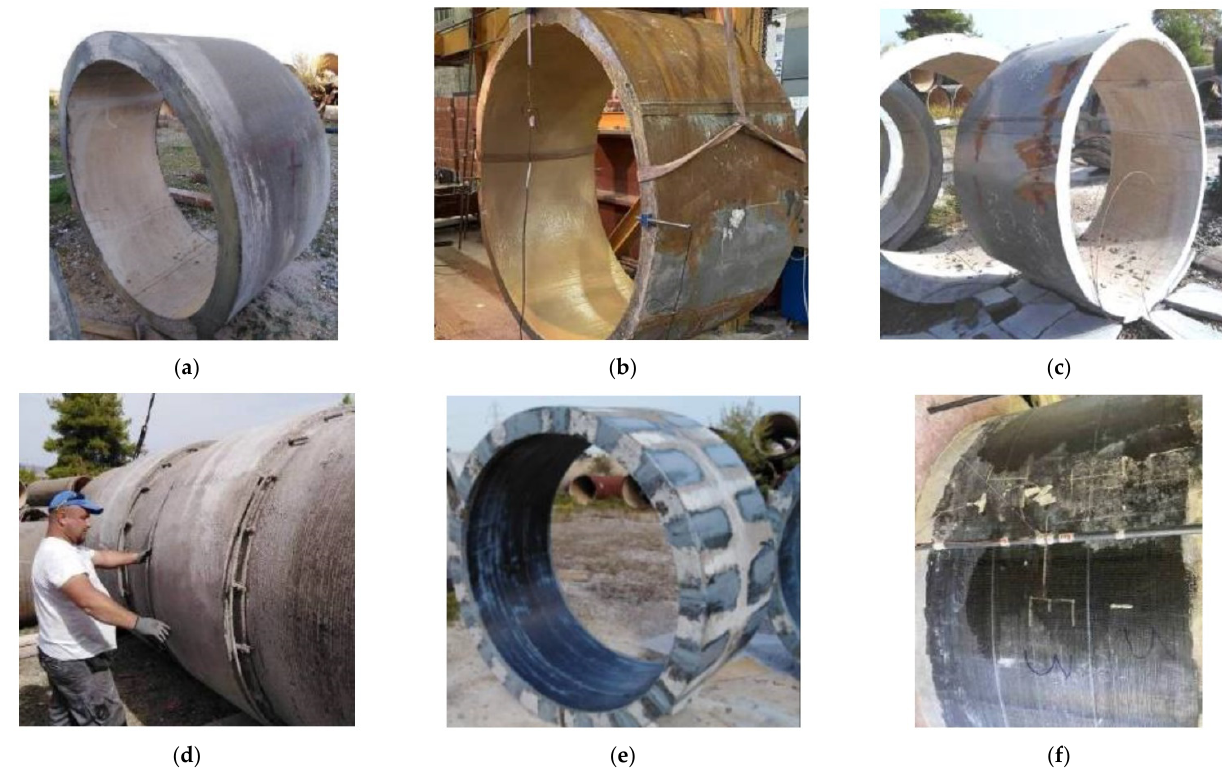
Figure 1. The various types of tested pipe specimens. ( a ) Original pipe with fully active prestressing wires, ( b ) Original pipe. Prestressing wires re-moved, ( c ) Original pipe. Prestressing wires removed, ( d ) External RC Jacket, ( e ) Internal CFRP jacket and ( f ) External CFRP jacket.